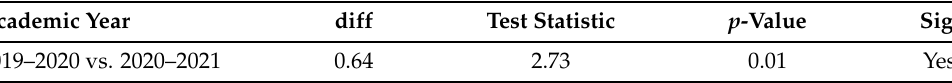
Table 18. Fisher test for means comparison with significance level